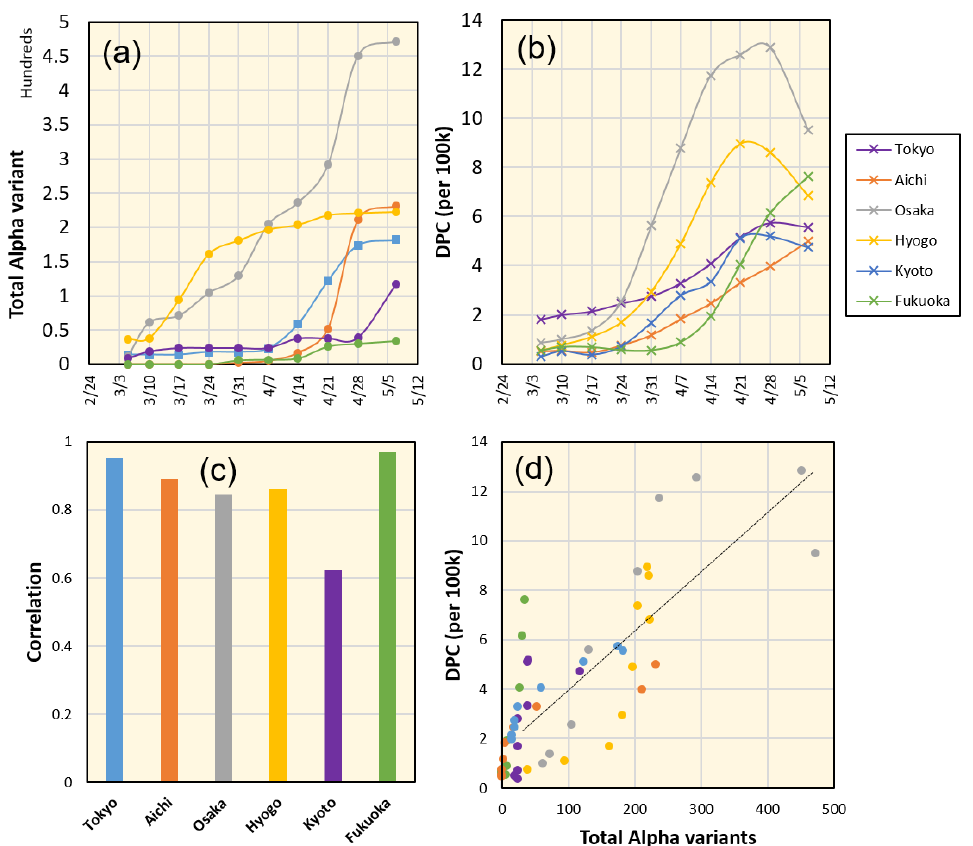
Figure 3. ( a ) Total confirmed cases with the Alpha variant and ( b ) DPC (per 100,000) in Tokyo, Aichi, Osaka, Hyogo, Kyoto, and Fukuoka. ( c ) Correlation between the total Alpha variant and the DPC per 100 k demonstrated high values. ( d ) Demonstration of time-independent high correlation between the Alpha variant and DPC (R 2 =